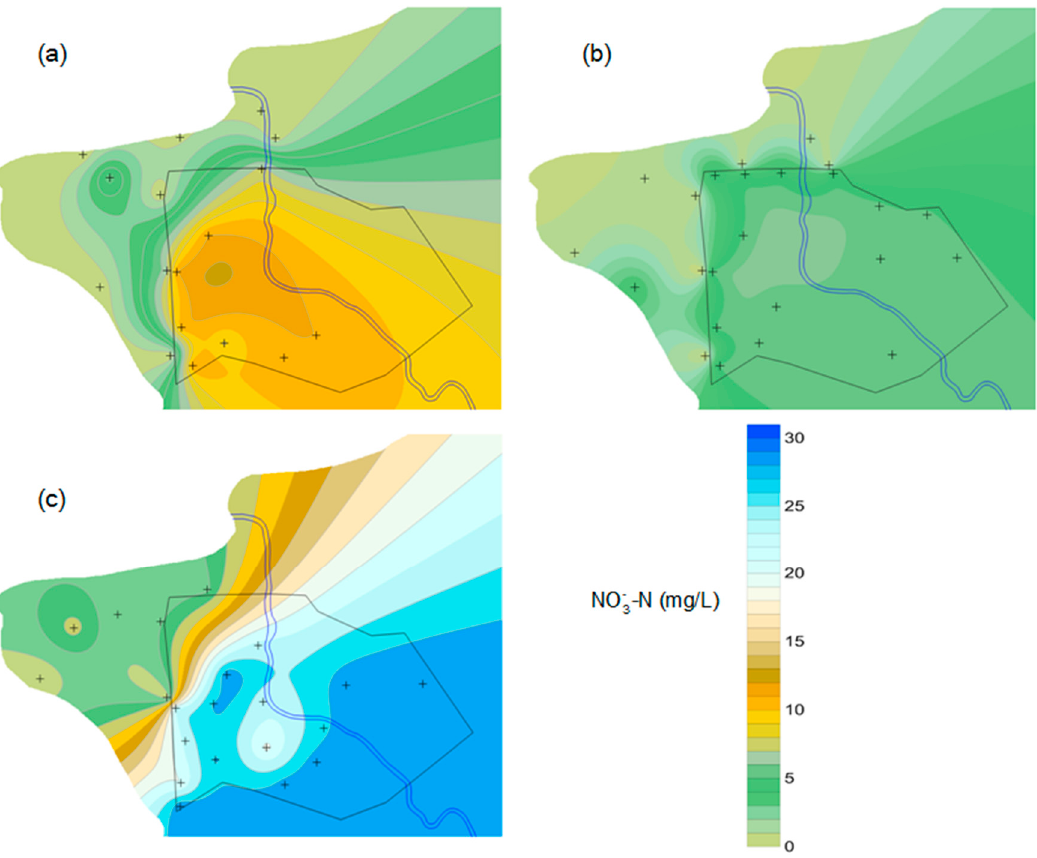
Figure 13. The variation of the distribution of groundwater nitrate concentration with time. ( a ) groundwater NO − -N level in July, 2014; ( b ) groundwater NO − 3 2015; ( c ) groundwater NO − -N level in August, 2015. 3